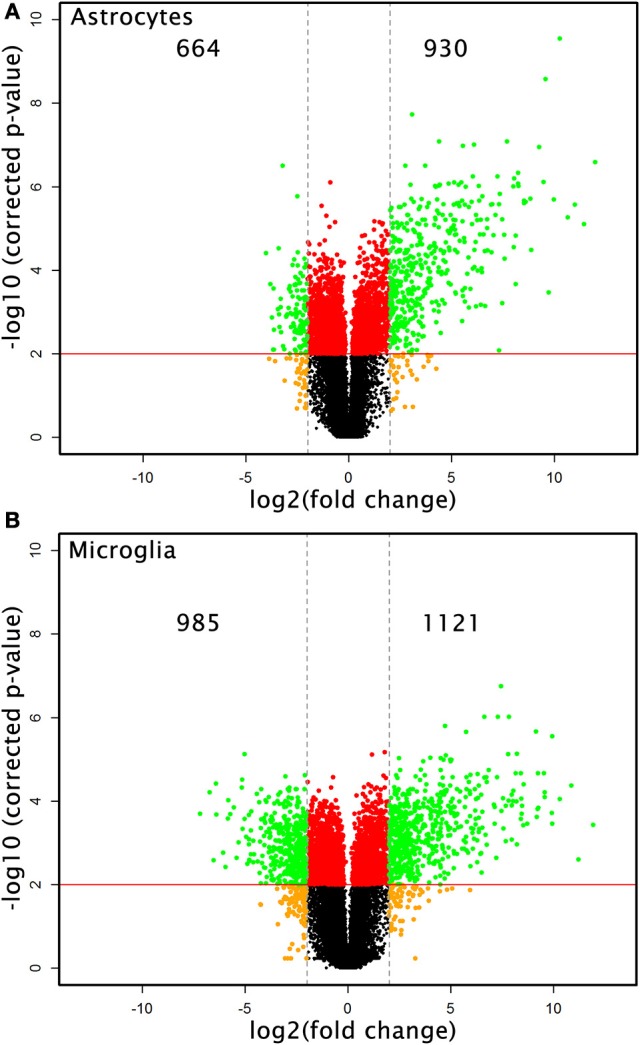
Transcriptional changes induced by Th1-derived effector molecules in microglia and astrocyte. Volcano plot shows the overall picture of differentially expressed genes (DEG) in astrocytes (A) and microglia (B) in response to Th1-derived effectors. Microarray analysis was performed on the RNA isolated from these cell types treated with medium or Th1-derived culture supernatants. Data generated from four independent experiments (n = 4). Fold changes were determined by normalizing the expression induced by Th1 treatment to their respective medium controls. Fold changes ≥2.0 and false discovery date of 0.01(corrected p < 0.01) was used as criteria to enrich DEGs.